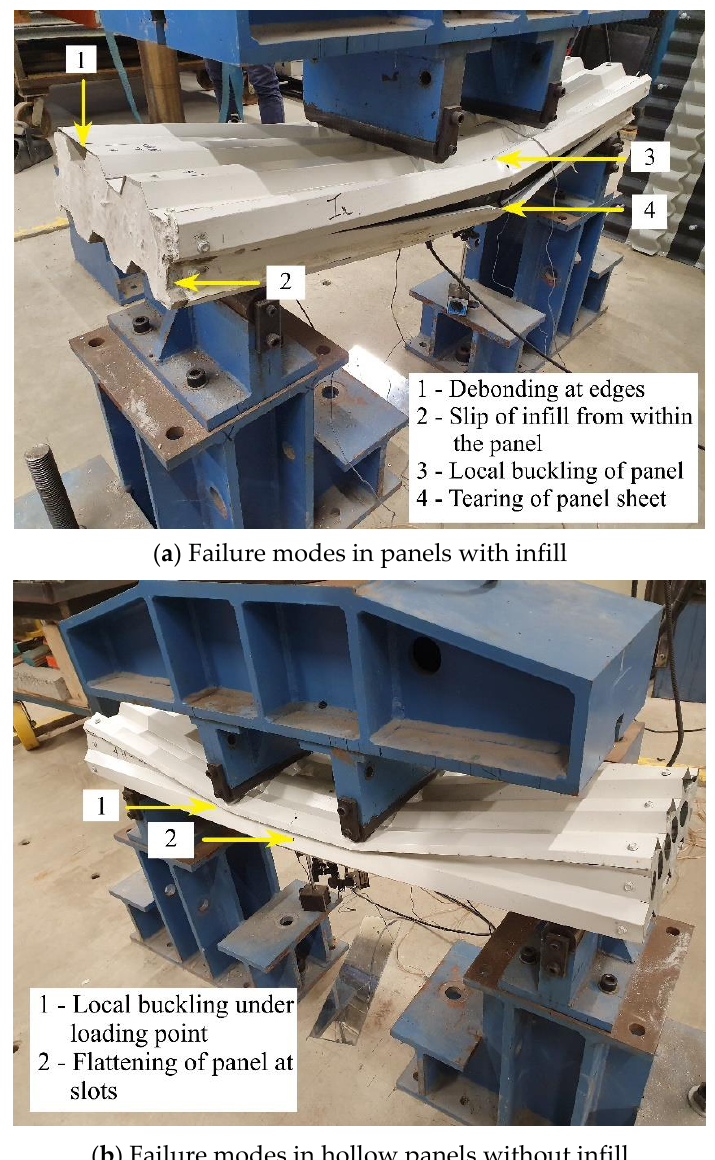
Figure 15. Comparison of failure modes in panels with and without infill.